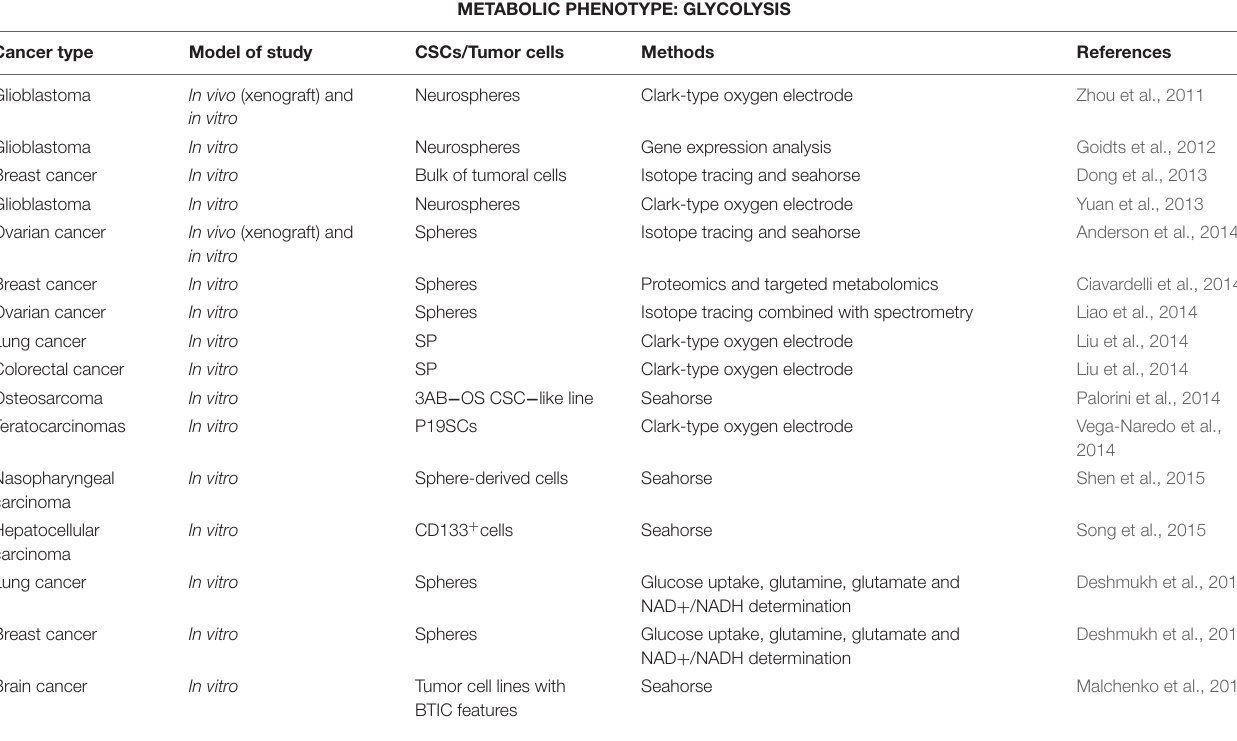
TABLE 1 | Stem-like cells with glycolytic metabolism for various cancer types (in chronological order). METABOLIC PHENOTYPE: